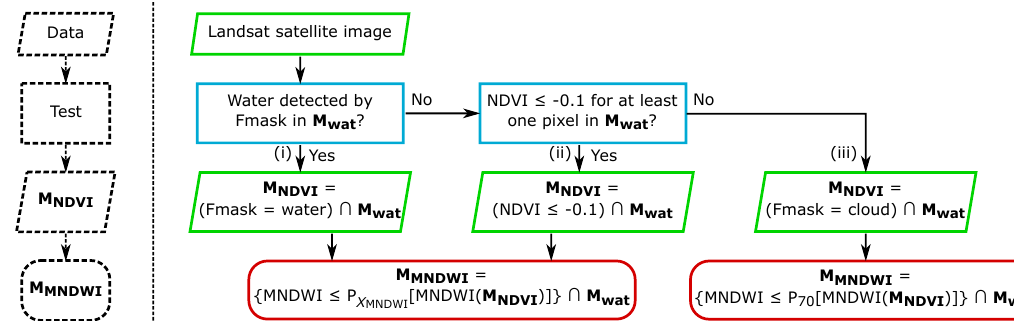
Figure 5. Two-dimensional dynamic classification procedure.